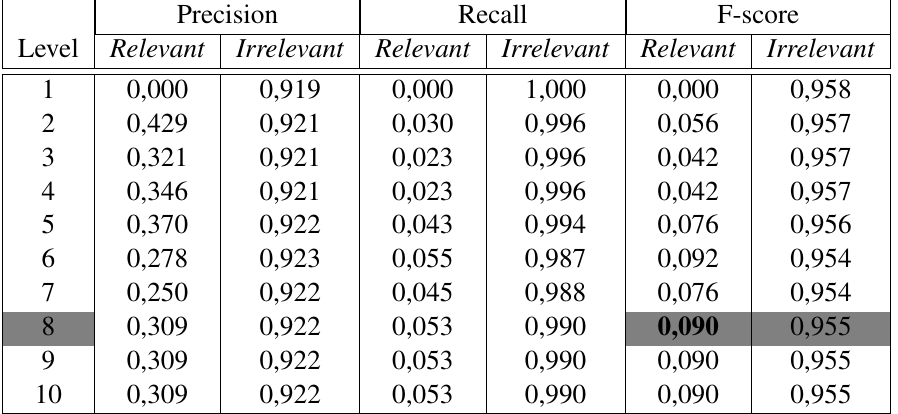
Table 3: Results achieved by the BN classifier for each MeSH level in the category G.